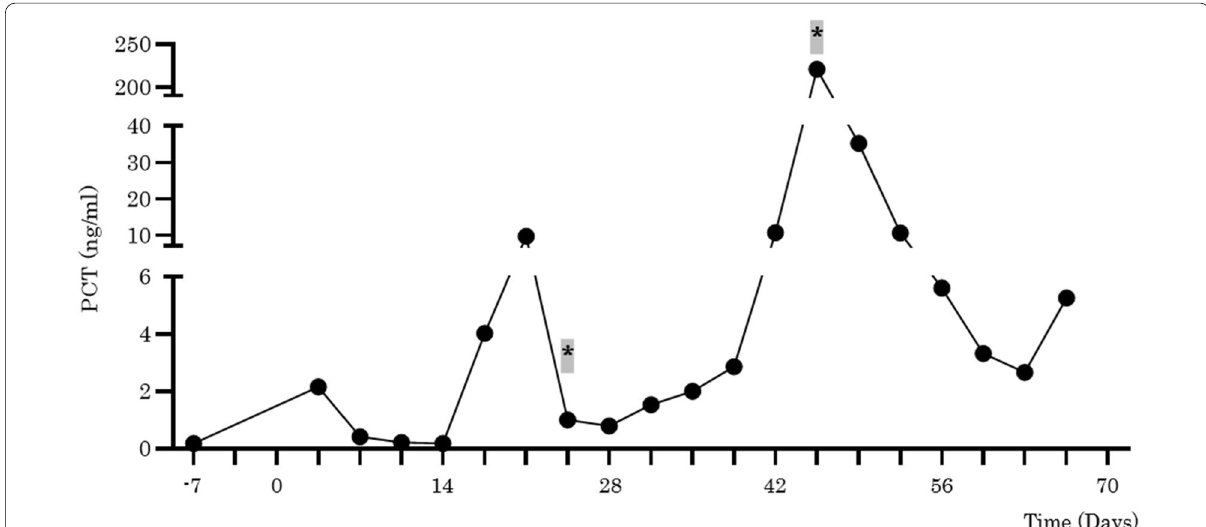
Fig. 3 The change of serum procalcitonin value in case 1 during the perioperative period. A bold asterisk highlighted in gray indicates positive blood culture of Clostridium butyricum . PCT, procalcitonin